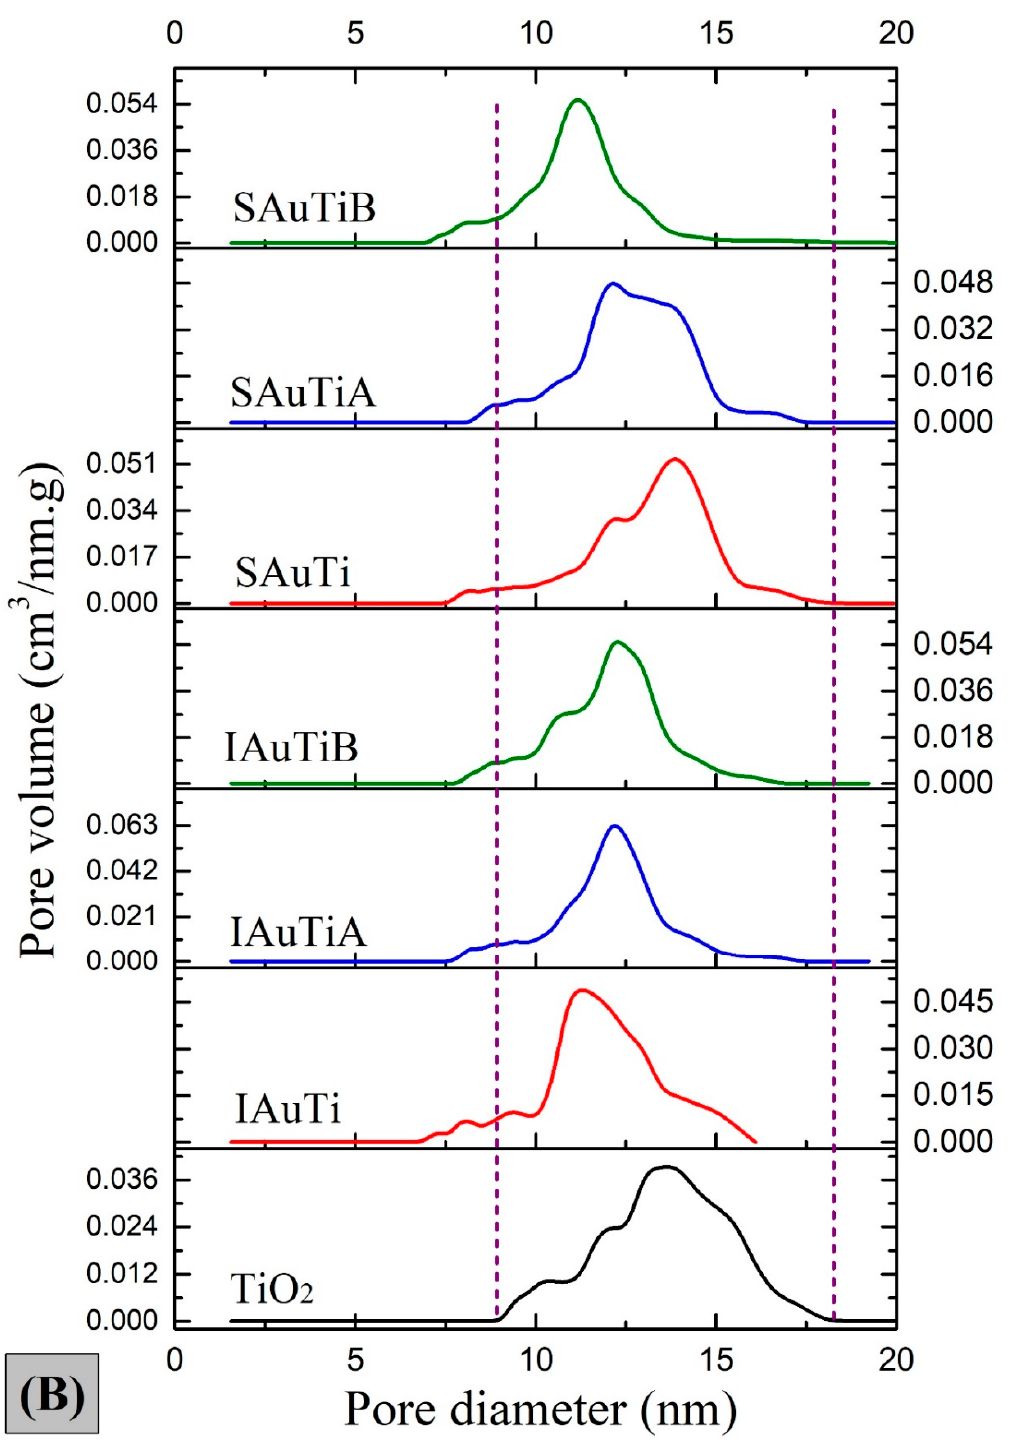
Figure 2. Nitrogen sorption results for Au / TiO 2 samples. ( A ) Sorption isotherms. ( B ) Average pore diameter by NLDFT.